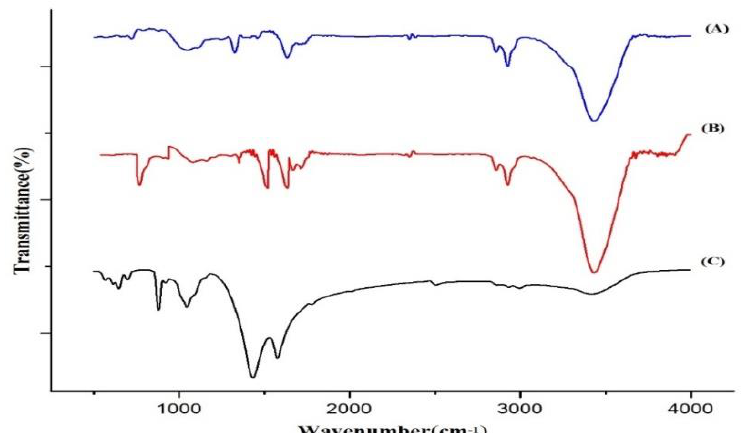
Fig. 1. FTIR spectroscopy of (A) virgin adsorbent, (B) modified adsorbent, and (C) virgin chitosan